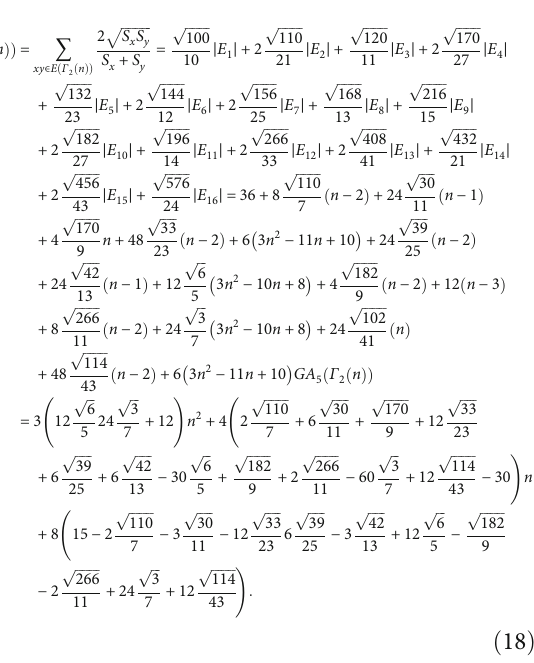
n Þ , Γ n Þ , and Γ 1 ð 2 ð